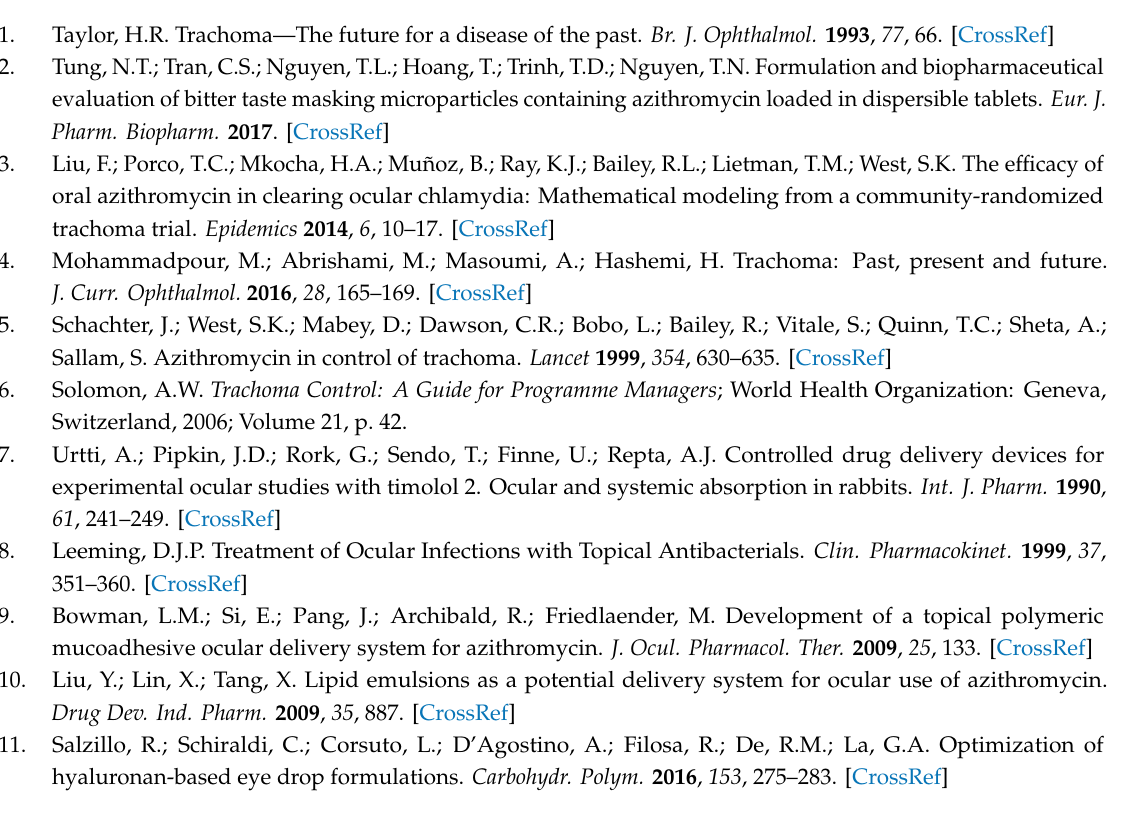
Figure S1: Cell viability against HCE-2 cells determined by MTT assay, Table S1: Scores for grading the severity of ocular lesions / grading system in the ocular irritation tests, Table S2: Evaluation criteria for eye irritation reaction, Table S3: Influence of 3% azithromycin eye drops on rabbit papillary diameter (cm, n =